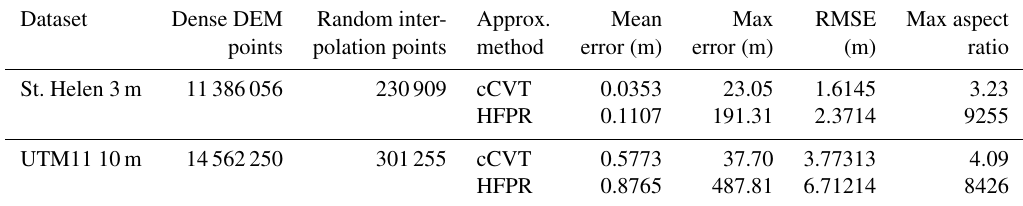
Table 2. Interpolated elevation RMSEs (m) at varied scale- transformation ratios. Dataset Approx. 5% ∗ 1% 0.5% 0.1% method St. Helens 3m cCVT 0.636 1.614 UTM11 10m cCVT